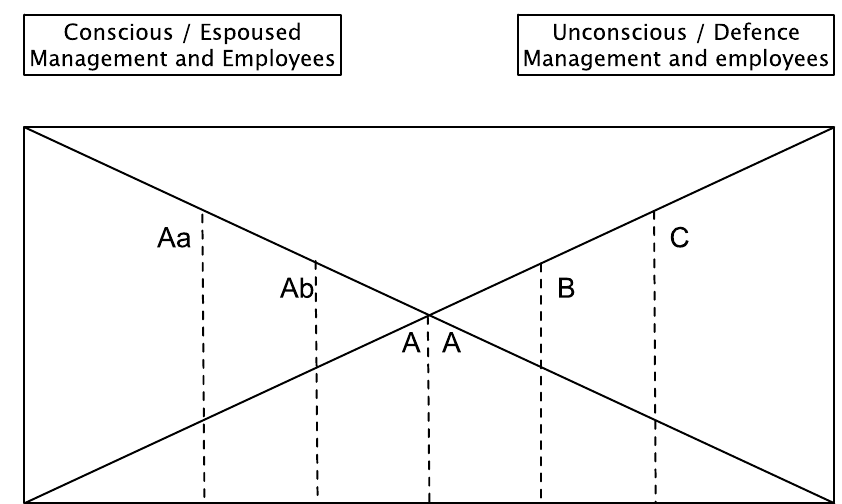
Figure 4. OI intertwined with OL.